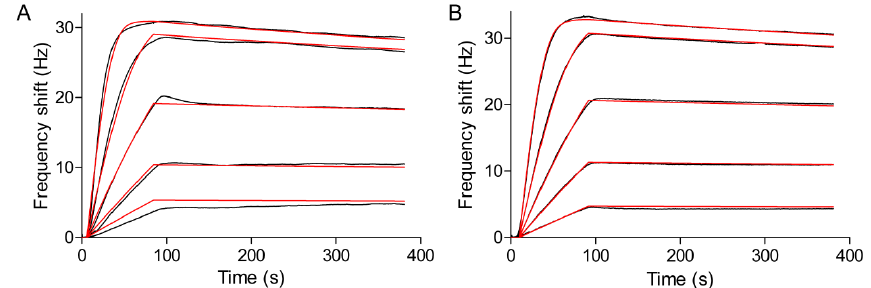
Figure 8. Kinetic evaluation of the interactions between myoglobin and anti-myoglobin 7005 antibody. Myoglobin at 0.25, 0.5, 1, 2 and 4 μg/mL (14.7, 29.4, 58.8, 118 and 235 nM) was injected over the sensor surface and the responses were recorded (black lines). Theoretical 1:1 fit using the Evaluation software (Attana) was overlaid (red lines). ( A ) Anti-myoglobin 7005 antibody was immobilized on the PDA-coated sensor surface; ( B ) Anti-myoglobin 7005 was immobilized on the carboxyl sensor surface via amine